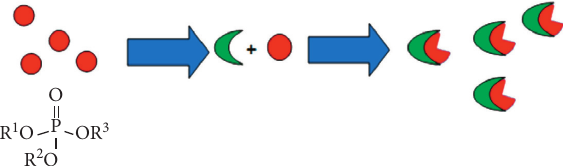
Figure 9: Schematic diagram of the stoichiometric bioscavenger mechanism. The red circle represents nerve agents, and the green represents the